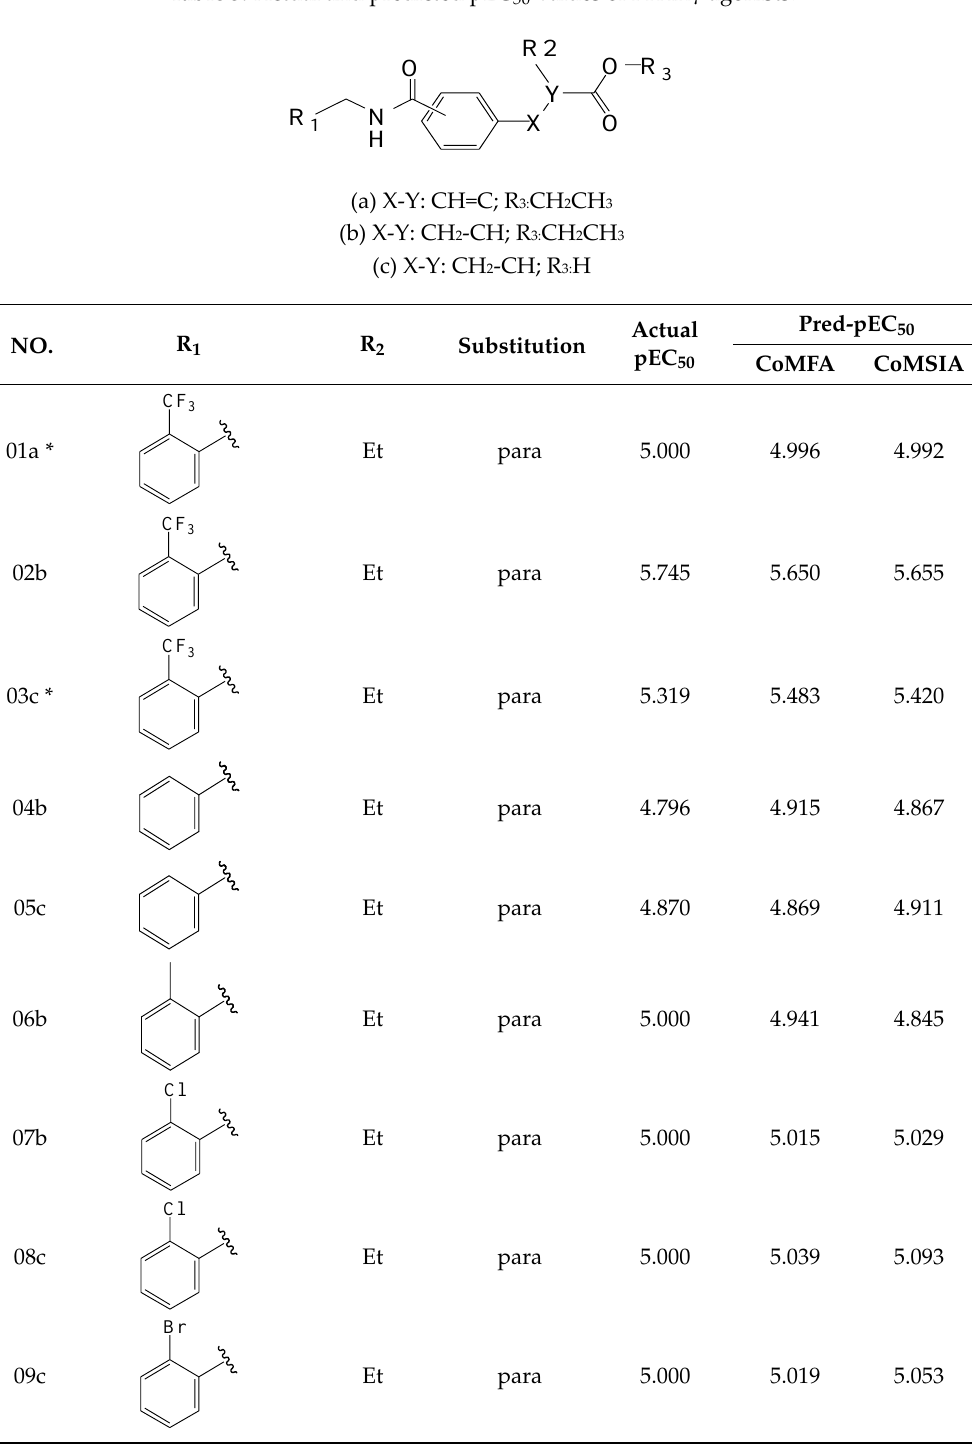
Table 3. Actual and predicted pEC 50 values of PPARγ agonists.